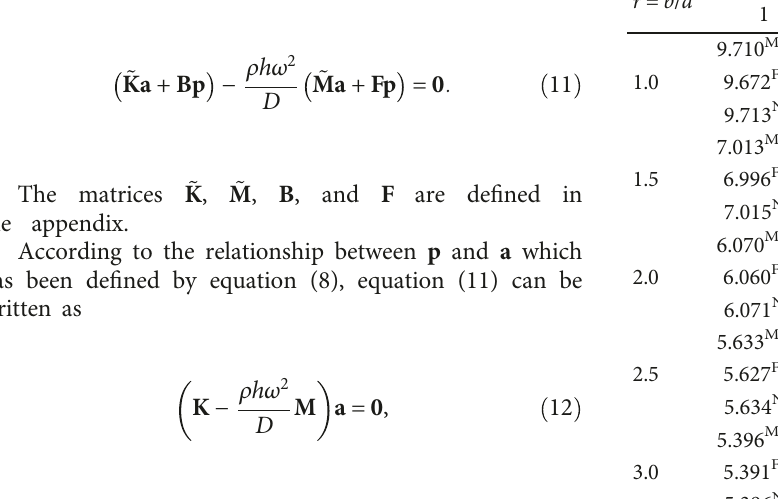
Table 3: Frequencies for S-S-S-S panel with di ff erent aspect ratios. r = b / a